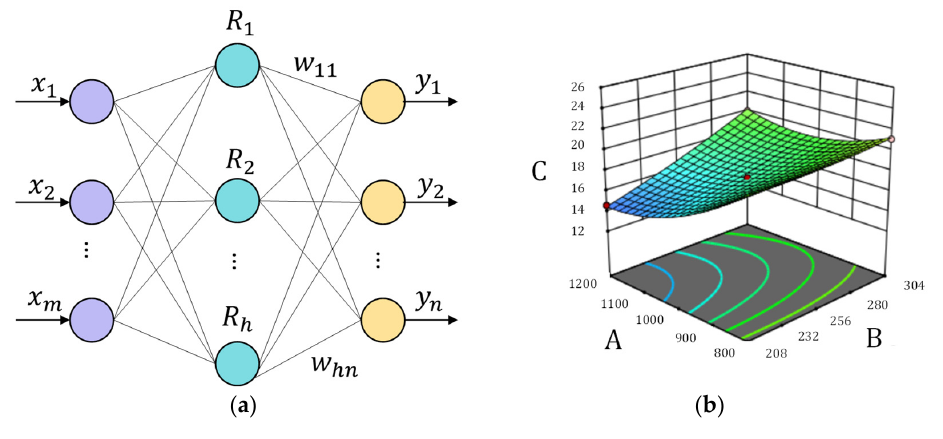
Figure 3. The illustration of ( a ) RBF ( b ) RSM.